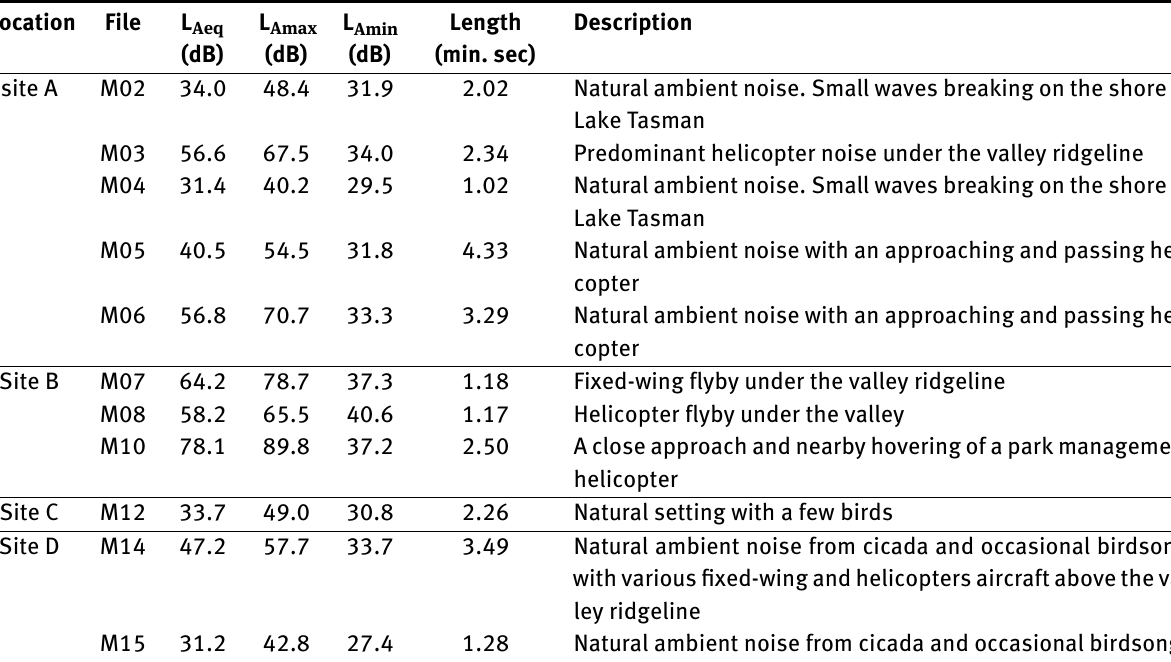
Table 1: Measurements in Aoraki/Mt. Cook National Park Location